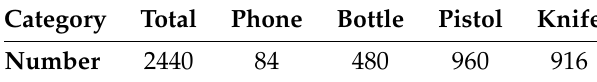
Figure 5. Model of experiment system. Table 1. Millimeter-wave radar human dataset.